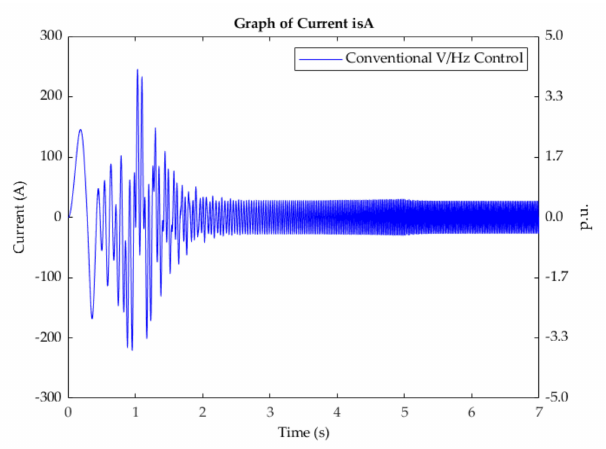
Figure 3. Phase A stator current, conventional V/Hz control, (0–50